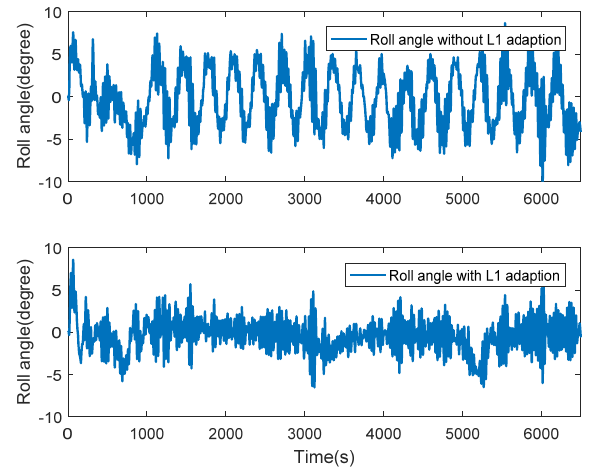
Figure 14. Roll reduction performances with and without 𝐿 (cid:2869) adaptive control.